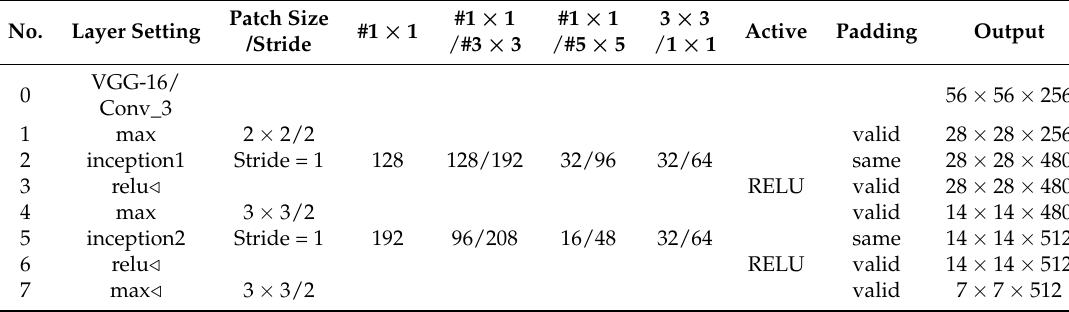
Table 2. The network architecture in feature extraction of our